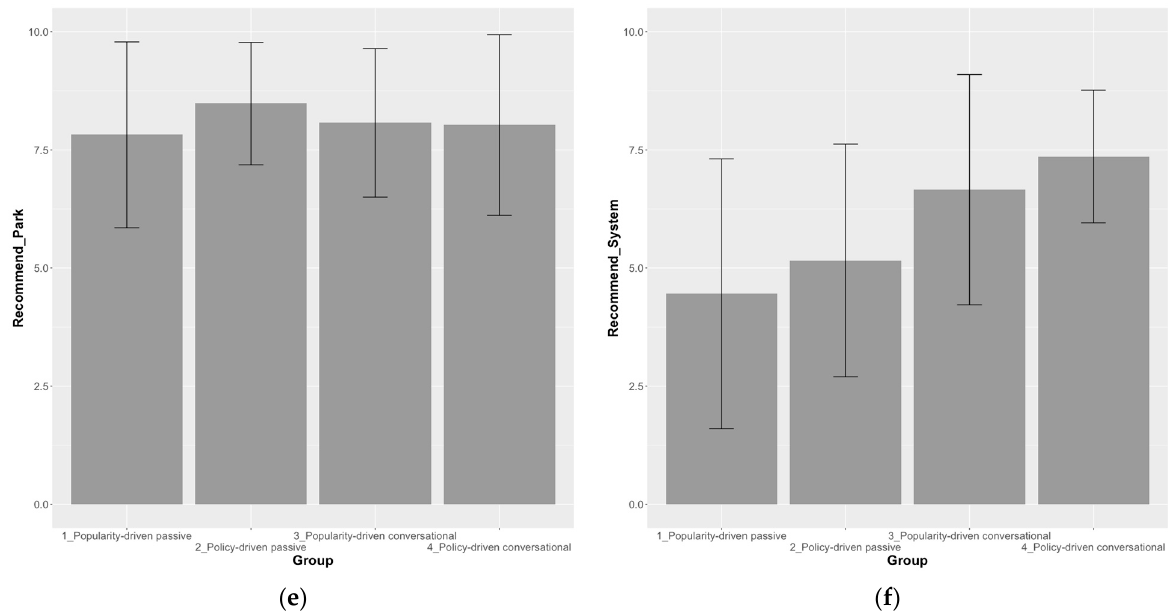
( e ) ( f ) Figure 2. Self-reported differences between groups on ( a ) positive emotions, ( b ) negative emotions, ( c ) overall grade for vacation, ( d ) intent to recommend Overijssel, ( e ) intent to recommend accommodation, ( f ) intent to recommend the recommender system. Table 1. Self-reported differences between groups including inferential comparisons to passive popularity-driven group.